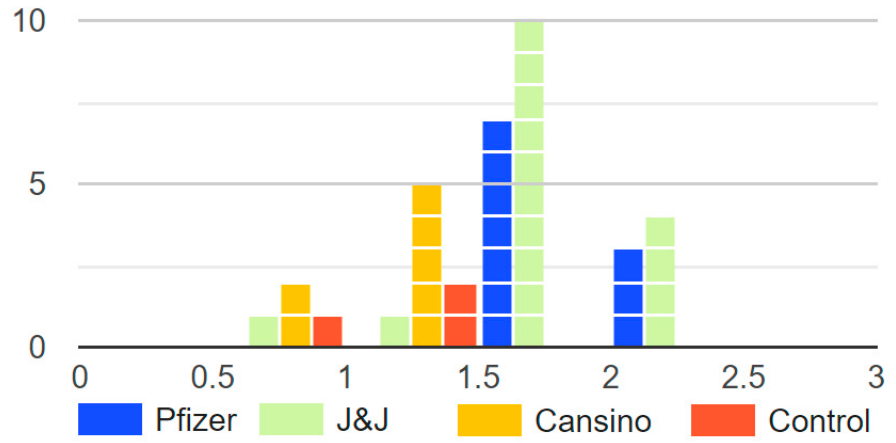
Figure 2. Histogram of the Log10NT50 of the breast milk from mother with different vaccination profiles. The figure displays how only Pfizer and J&J groups had Log10NT50 over 2, and that the control (no vaccine) and CanSino groups had lower Log10NT50.